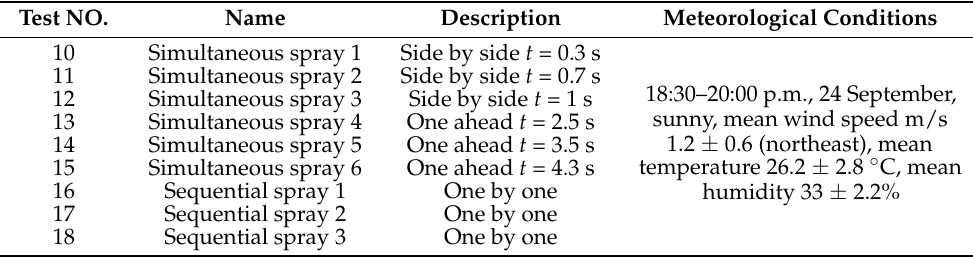
Table 2. Experimental setup and conditions of 9 tests at 5 m/s. Test